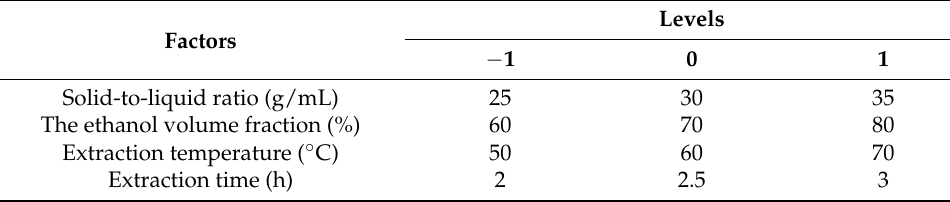
Table 3. Factor levels of response surface